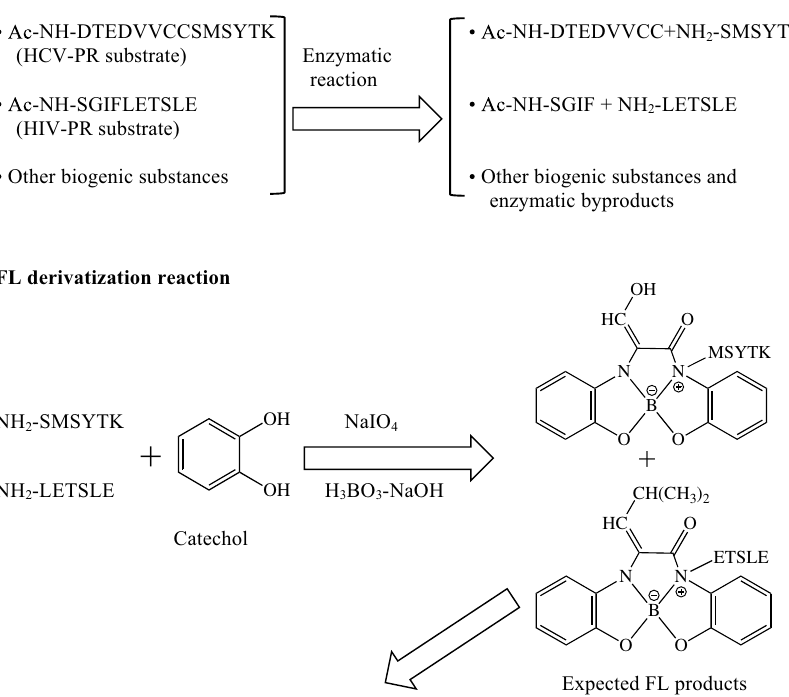
Figure 1. Schematic protocol for FL assay of HCV-PR and HIV-PR activities. The N-terminal acetyl peptides were used as substrates and specifically hydrolyzed by each protease. The generated peptides were selectively converted to the FL compounds by a fluorogenic reaction with catechol, sodium periodate, and borate. FL products were analyzed by HPLC with fluorescence